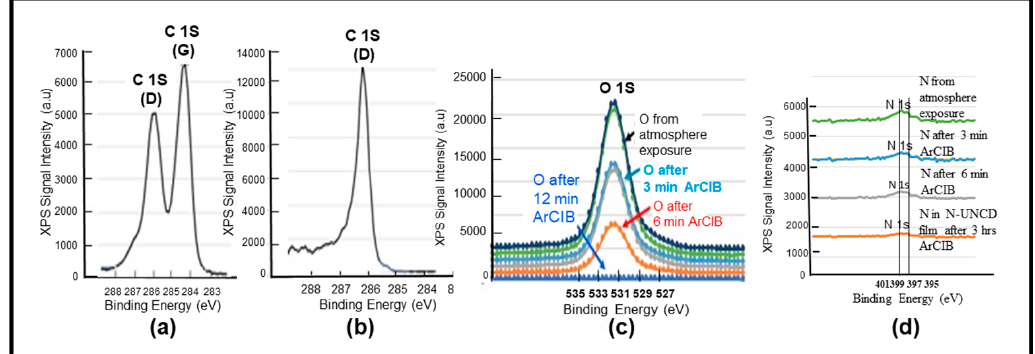
Figure 6. XPS spectra of key atoms in the N-UNCD film grown on NG/Cu anode: ( a ) C 1s peaks (G- related to the sp 2 C bonds characteristic of graphite [19]) corresponding to adventitious C atoms from the atmosphere adsorbed on the N-UNCD film surface)/(D- related to the sp 3 C bonds characteristic of diamond [19]); ( b ) C 1s peak after 12 min ArCIB bombardment, ( c ) O 1s peak, corresponding to O atoms adsorbed from the atmosphere, which disappear after 12 min ArCIB bombardment; ( d ) N 1s peak (double structured), revealing N atoms adsorbed from the atmosphere, which are practically eliminated after 6 min ArCIB bombardment, with the remaining small N 1s intensity peak, after 3 h. ArCIB bombardment related to N atoms inserted in the N-UNCD film during growth.